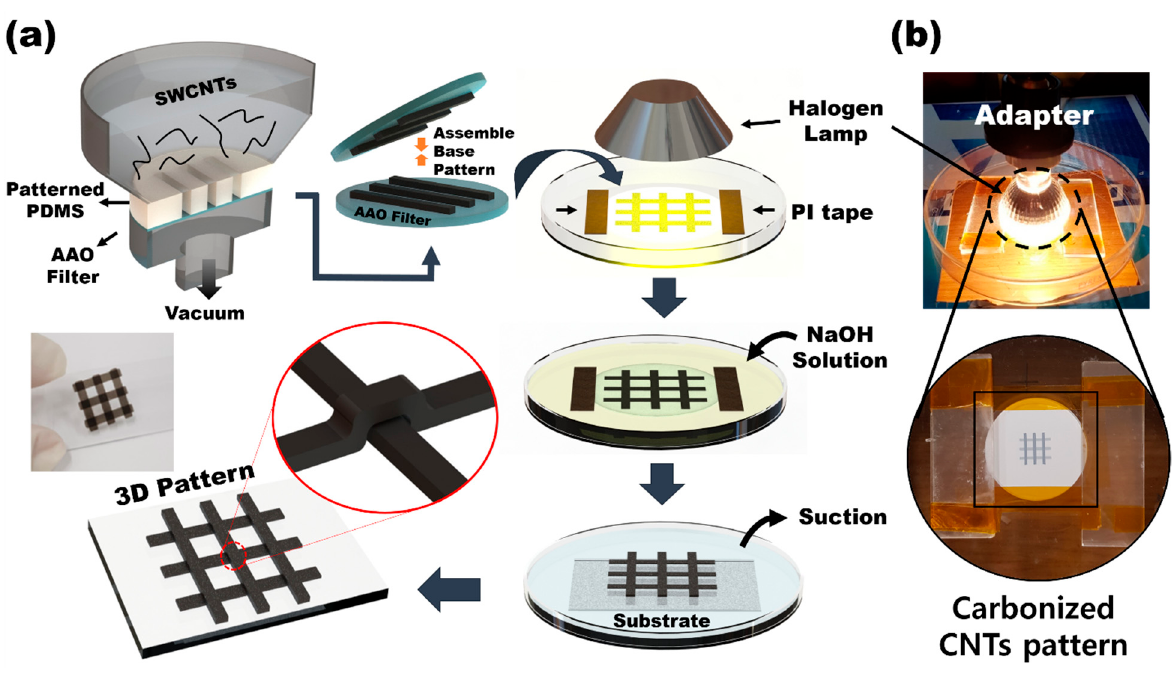
Figure 1. ( a ) Schematic diagram of the multiple steps of vacuum filtration to make base CNT patterns and assembling 3D patterns; PI tape is used for alignment and contact. ( b ) Induction of carbon welding using halogen lamps.